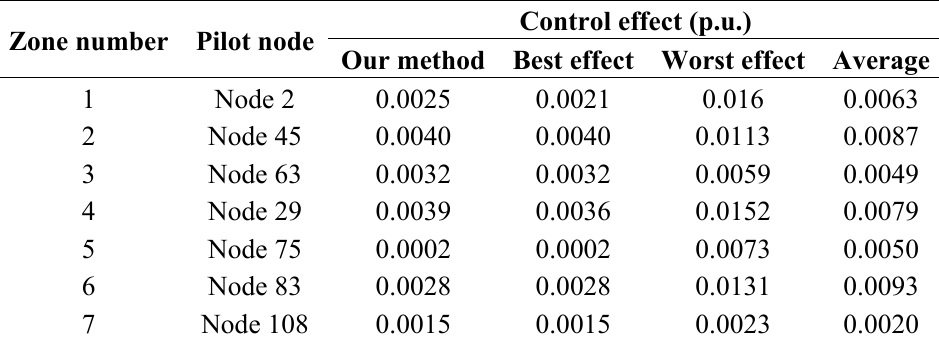
Table 3. Simulation results for the IEEE 118-bus system.